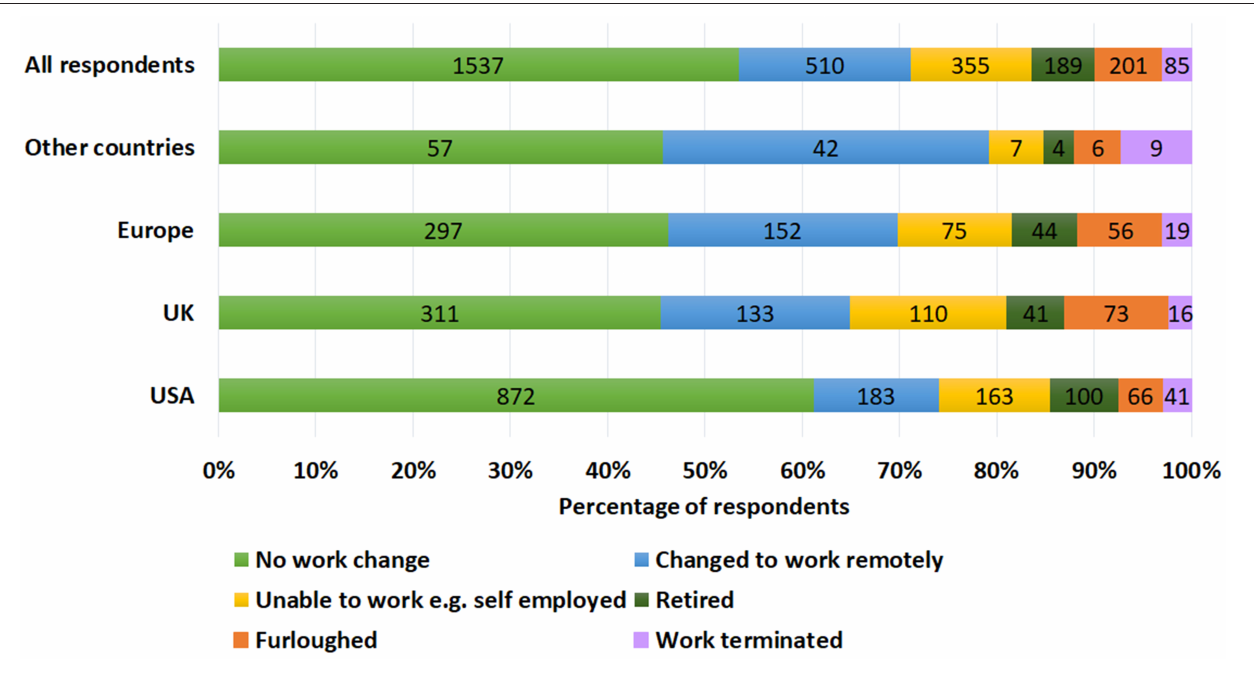
FIGURE 7 | Comparison of changes to work patterns during the COVID-19 pandemic across different